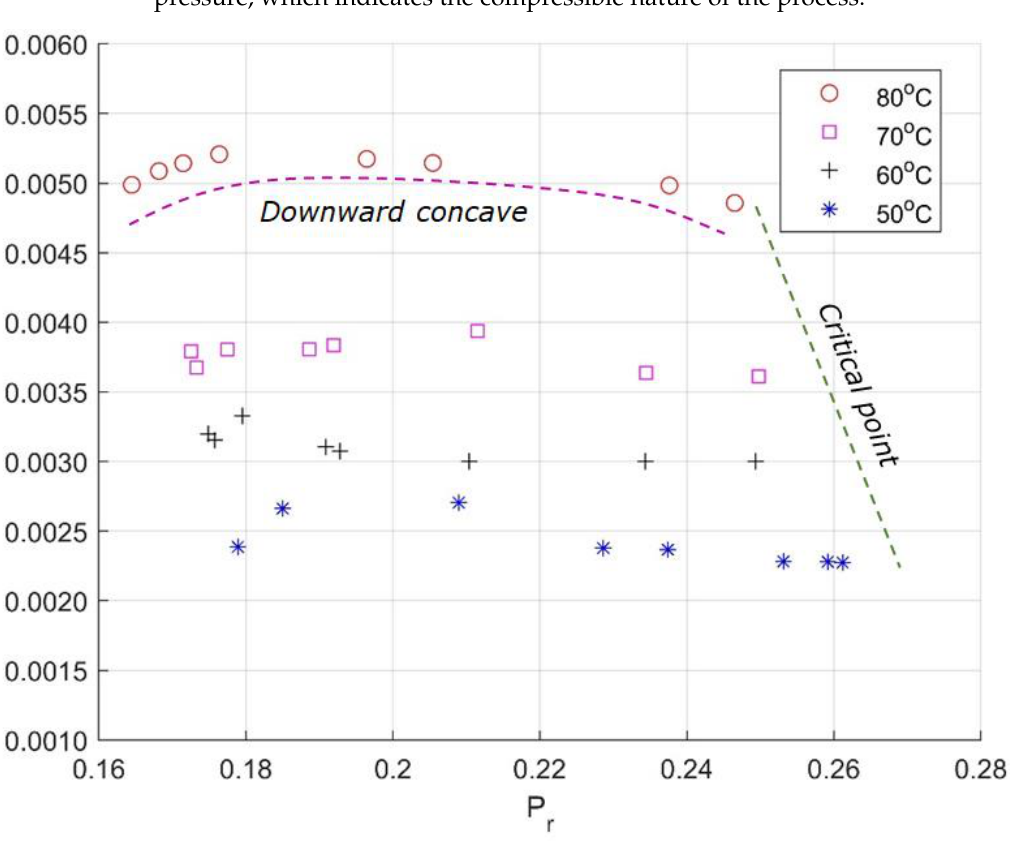
Figure 9. Mass flux (J) with respect to feed flow (Q fi ).